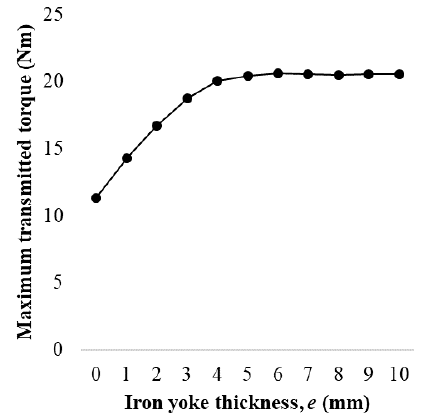
Figure 12. The maximum transmitted torque versus the iron yoke thickness.